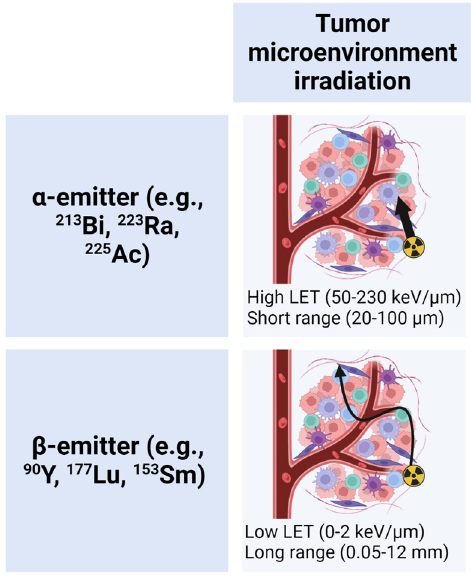
Figure 1. Tumor microenvironment irradiation by alpha-emitters versus beta-emitters. Physical property differences of alpha particles and beta particles lead to different tumor irradiation patterns. Alpha particles (high linear energy transfer (LET), short tissue range) traverse 1–2 cell diameters with a high density of ionization events along their track. Beta particles (low LET, long tissue range) travel millimeters in tissue with sparse ionization events, and have the potential to irradiate many structures in addition to the cell of targeted radionuclide therapy (TRT) uptake. Created with Bio- Render.com.